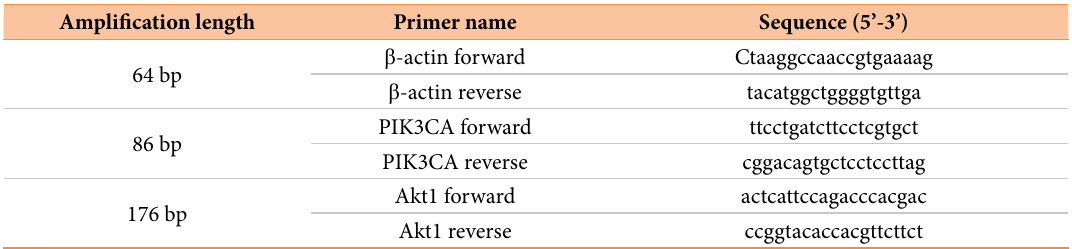
Table 1 - Primer sequences for real-time fluorescence quantitative polymerase chain reaction.